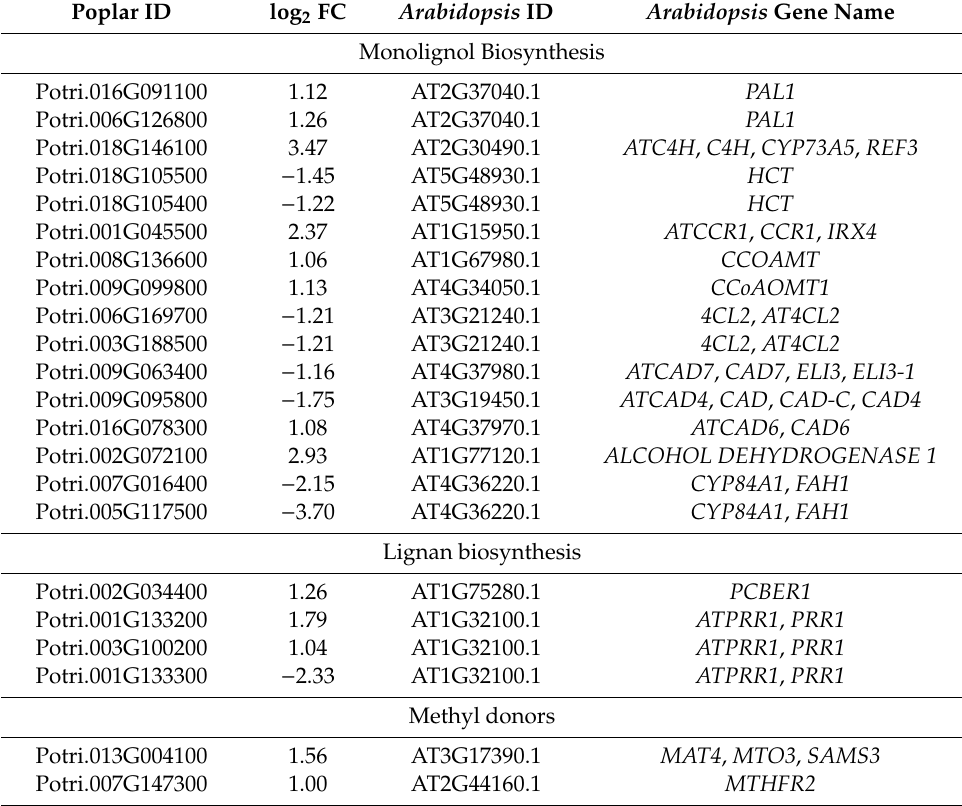
Table 2. Di ff erentially expressed genes involved in monolignol and lignan biosynthesis in 21 dai galls versus uninfected